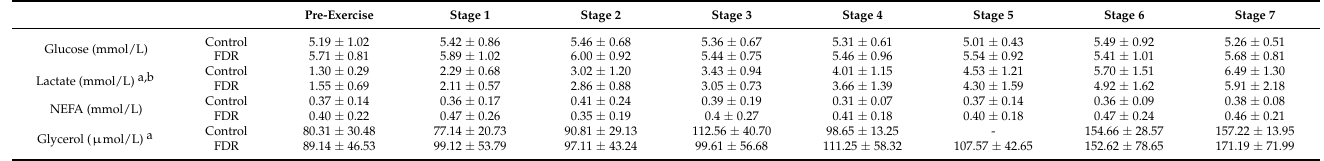
Figure 2. 13 C tracer concentrations in plasma and breath in aging women with or without family history of type 2 diabetes. Concentrations of 13C-palmitate in plasma ( A ) and the percent dose recovery of 13C in breath ( B ) in controls (dotted line) and in first-degree relatives (full line). † Signifies the last stage of exercise completed by the participant (stage 3, n = 2; stage 4, n = 1, stage 5, n = 2; stage 7, n = 14). AUC = Area under the curve. Data shown as mean ± SD. Table 2. Plasma metabolites immediately before and during submaximal